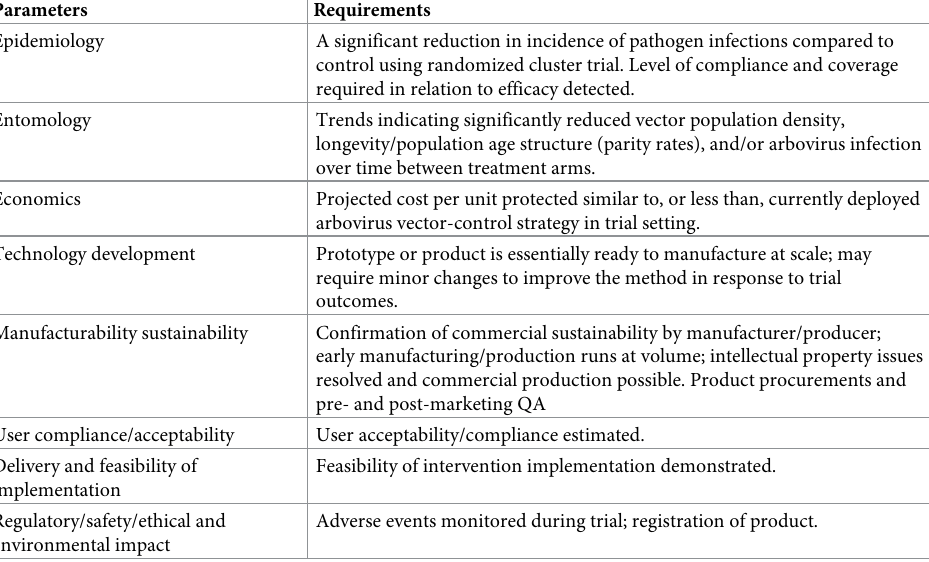
Table 1. Example epidemiological − entomological parameters intended to demonstrate public health value of a new vector-control tool 1 .